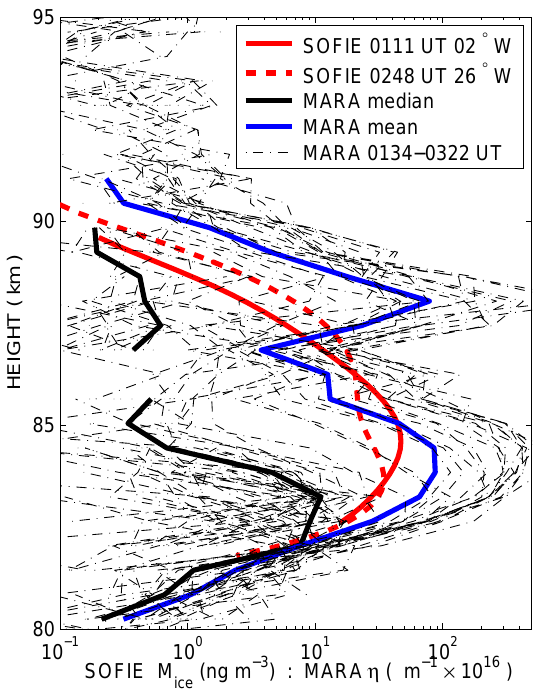
Fig. 1. Profiles of ice mass density measured by SOFIE and of PMSE volume reflectivity measured by MARA on 15 January